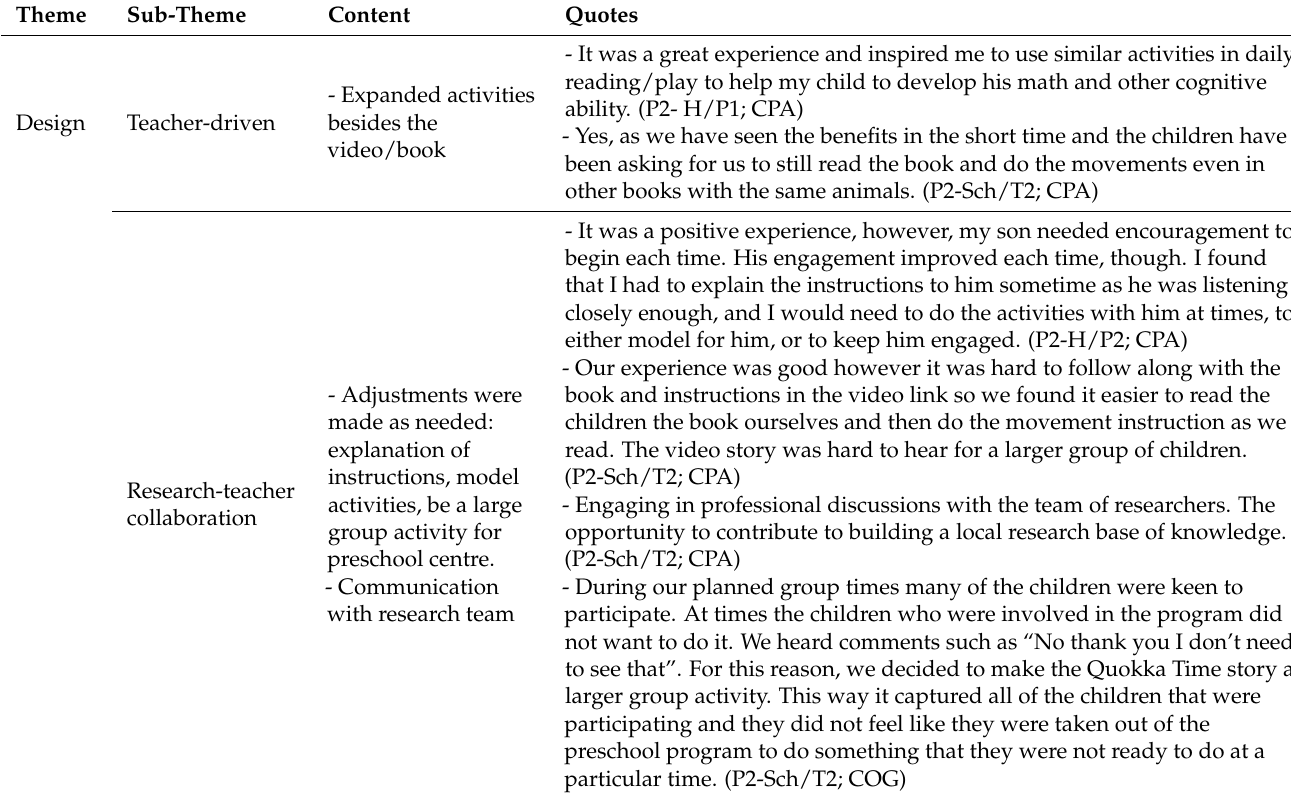
Table A1. Summary of Thematic Analyses from Phases 1 and